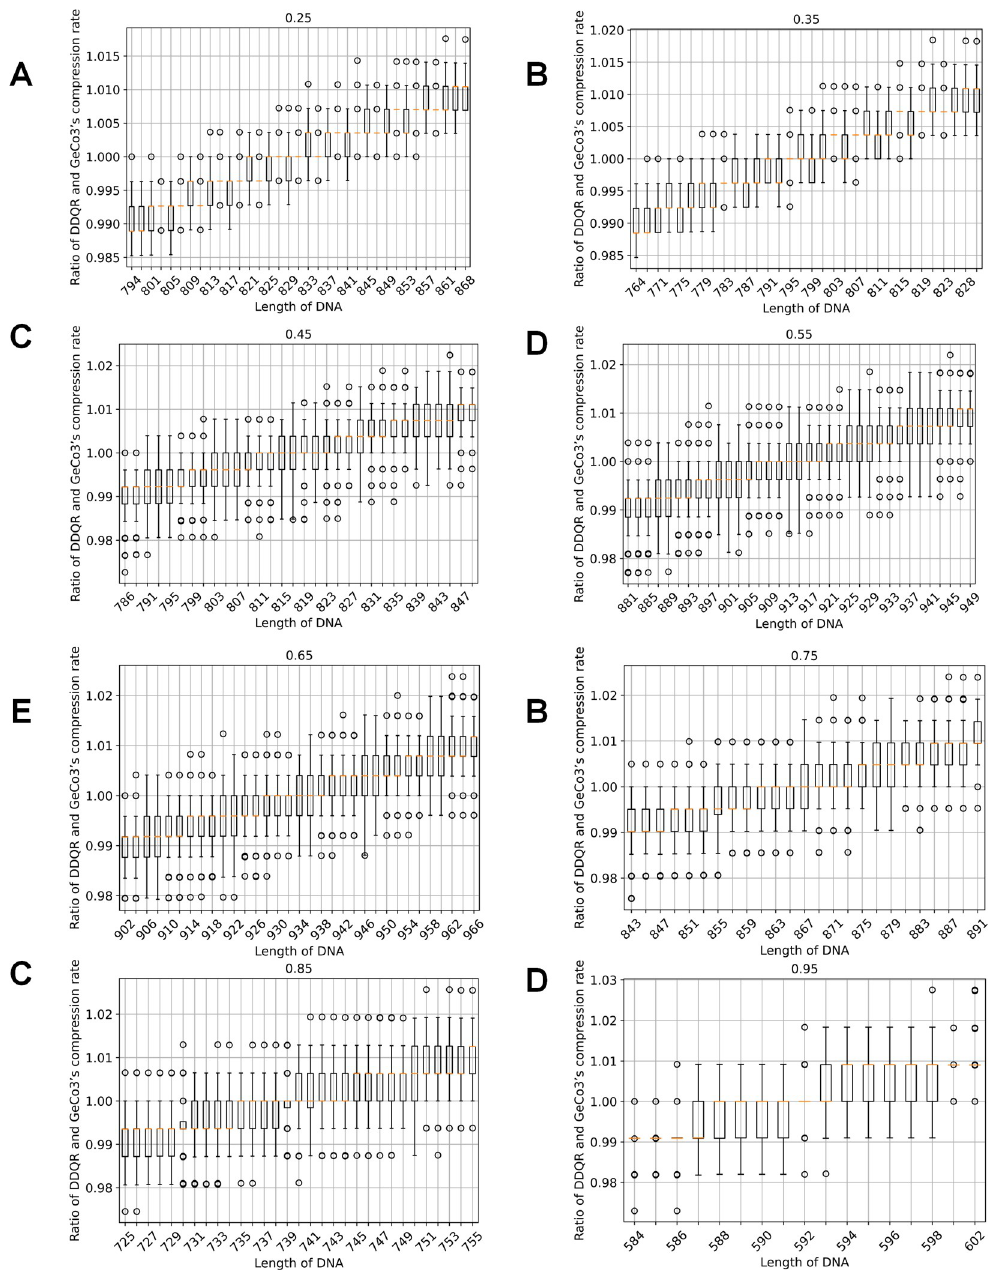
Fig 2. Comparison of compression rates of DDQR and Geco3 using simulated data around the region where the performance of DDQR exceeds that of GeCo3. The panels represent results obtained for DNA sequences having a particular composition: 25% (A), 35% (B), 45% (C), 55% (D), 65% (E), 75% (F), 85% (G), 95% (H). The x-axis is the DNA sequence length. The y-axis is the ratio of DDQR and GeCo3’s compression